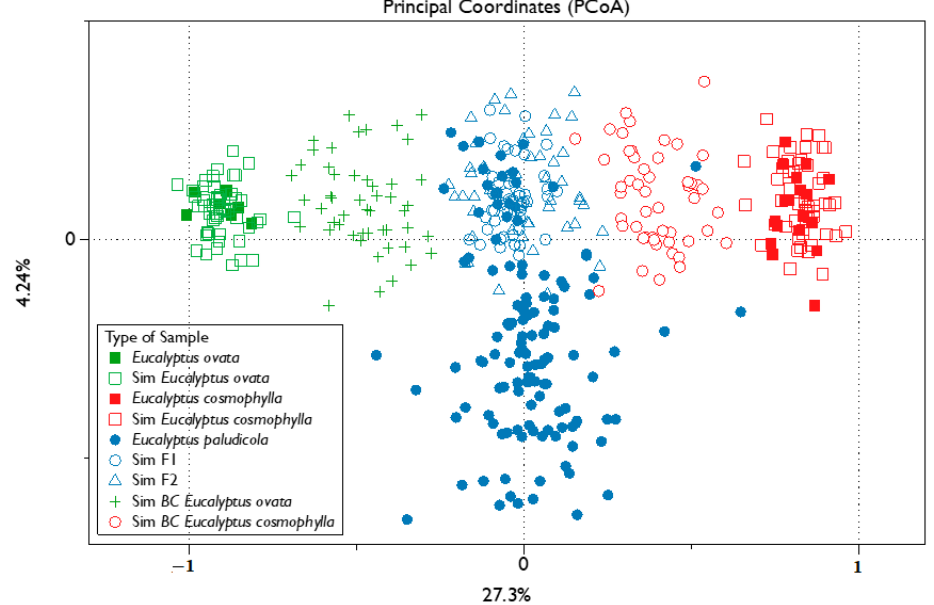
Figure 3. Principal Coordinates Analysis for real and simulated genetic data for Eucalyptus paludicola , E. ovata , E cosmophylla . First (F 1 ) and second (F 2 ) generation, back cross with E. ovata and back cross with E. cosmophylla were all simulated in HYBRIDLAB to depict the positioning of E. paludicola .